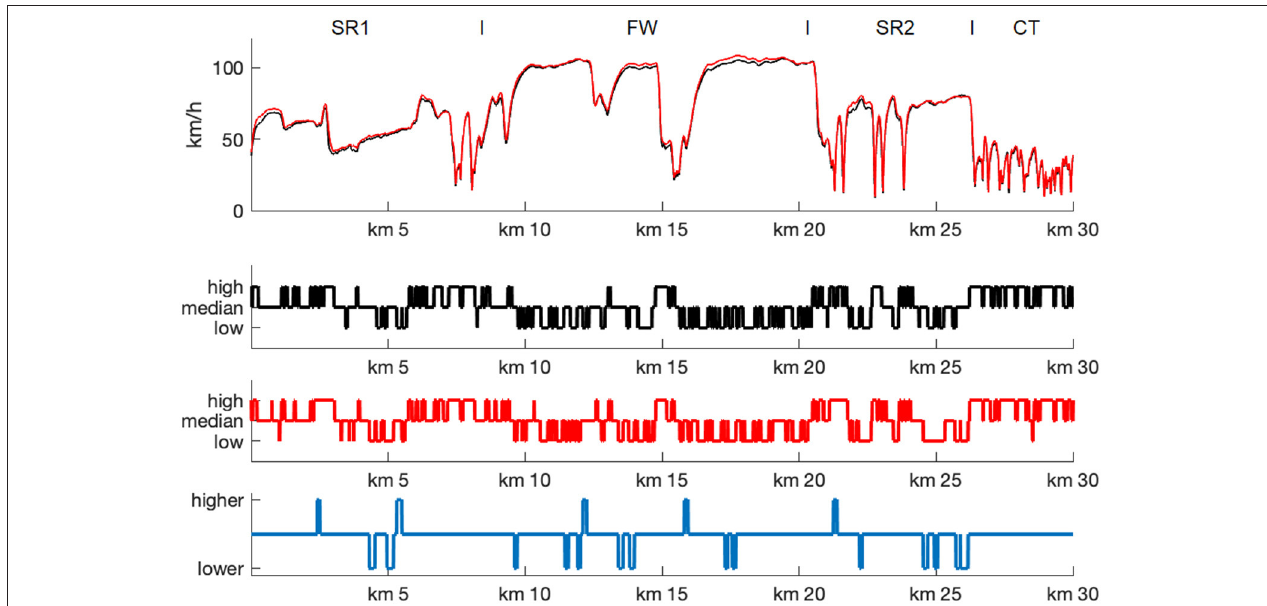
FIGURE 7 | EEG-based estimation of task load. Task load (low, medium, high) as function of driving route for MP1 (black) and MP2 (red), and MP1 – MP2 differences (blue). For each time point individual task load estimations of each participant were assigned to fix waypoints and then averaged separately for 10-meter track segments. For comparison, mean driving speed (upper row) is also shown. SR1, first state road; FW, freeway; SR2, second state road; CT, city traffic.